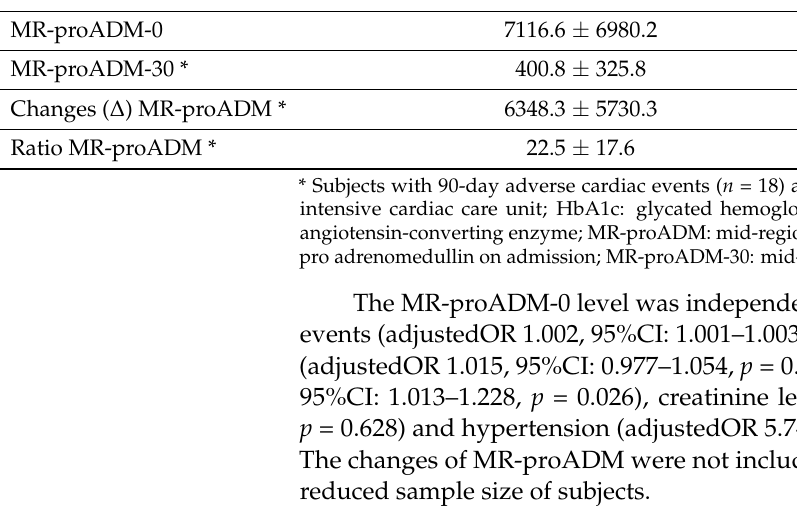
Table 6. Univariate and multivariable analysis for 90-day follow up adverse cardiac